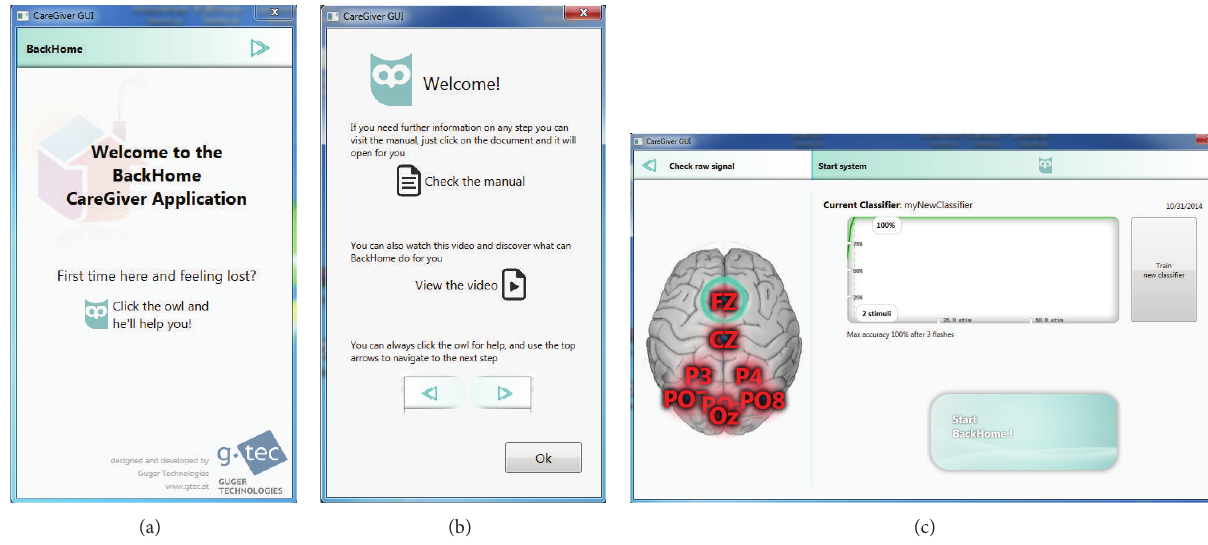
Figure 7: Care giver interface. The interface has been designed to optimally guide the care giver through the setup process step by step (a) and provide access to help and support information (b) on every screen. Only those information and controls are shown which are necessary to accomplish the current step (c) or advance to the next one when finished or go back to the previous one.